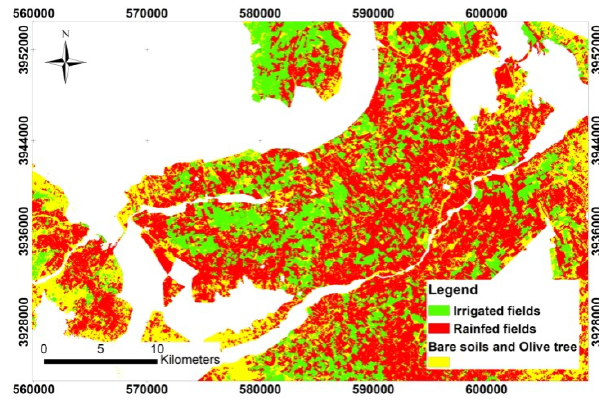
Figure 4. Irrigation map using soil moisture parameters for irrigated and non-irrigated